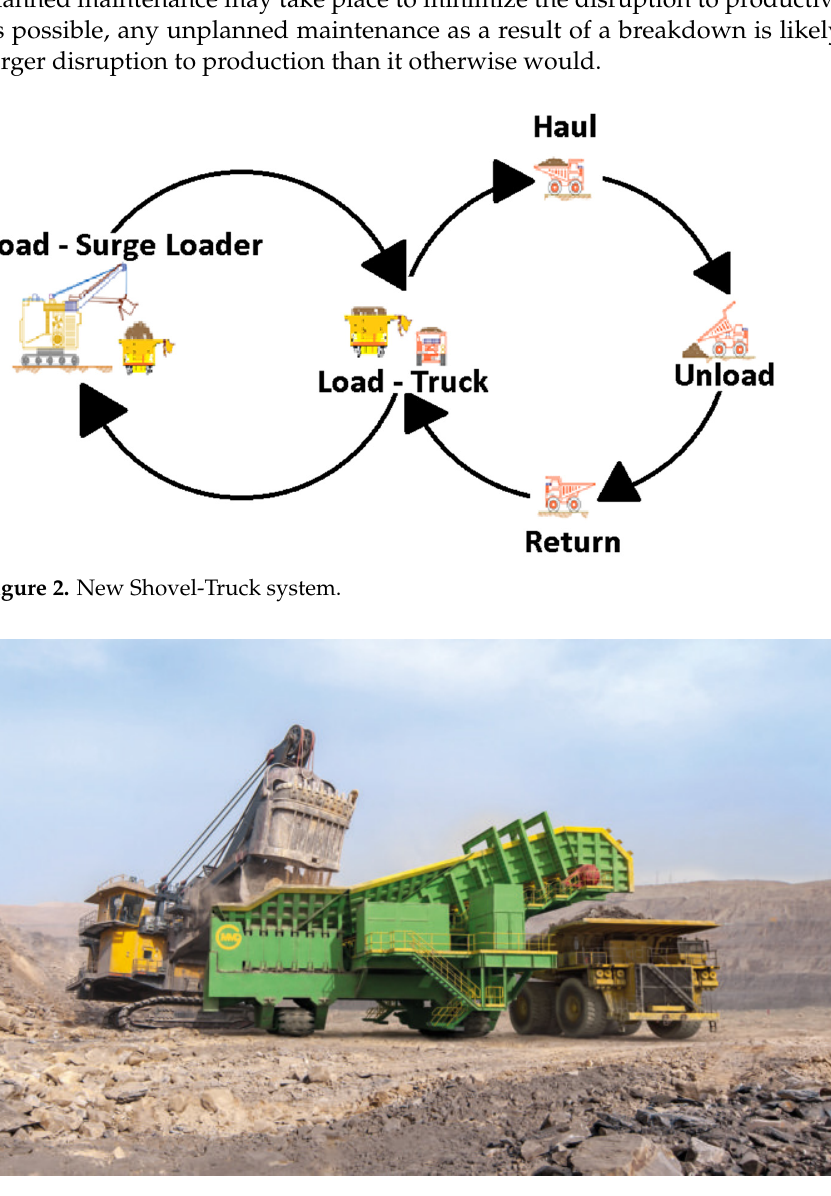
Figure 3. Fully Mobile Surge Loader